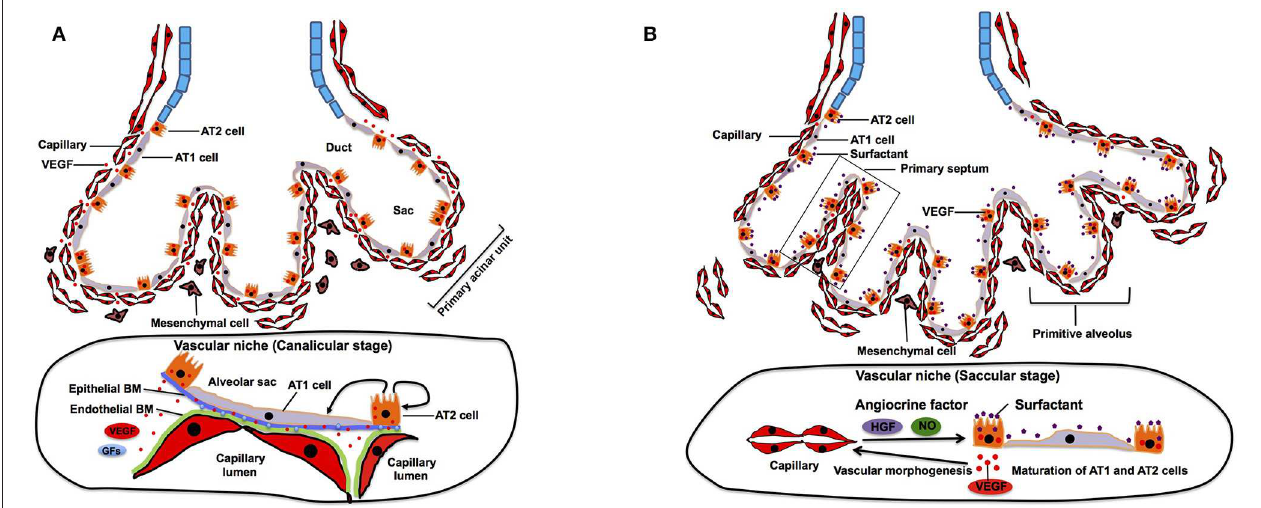
FIGURE 2 | Canalicular and saccular stage. (A) During canalicular stage, distal airway is further expanded and vascularized by capillaries. Distal multipotent epithelial progenitor cells differentiate into AT1 and AT2 at the alveolar wall. The source of VEGF is completely shifted from mesenchyme to epithelium, which facilitates closer interaction between epithelium and endothelium. This close interaction also contributes to differentiation of the epithelial progenitor cells into AT1 and AT2 cells. Endothelial and epithelial basement membrane (BM) fuse to form layered BM. BM-bound VEGF and other growth factors (GFs) modulate self-renewal and differentiation of AT2 cells. (B) During saccular stage, primitive alveoli are formed, in which alveolar epithelium and capillary endothelium form the interface for gas-exchange by sharing their basement membrane. This process includes further thinning of AT1 cells. Thick primary septa, which include double-layered capillaries, are formed between the walls of primitive alveoli. EC-derived angiocrine factors such as HGF and NO stimulate alveolar epithelial cell maturation and morphogenesis.